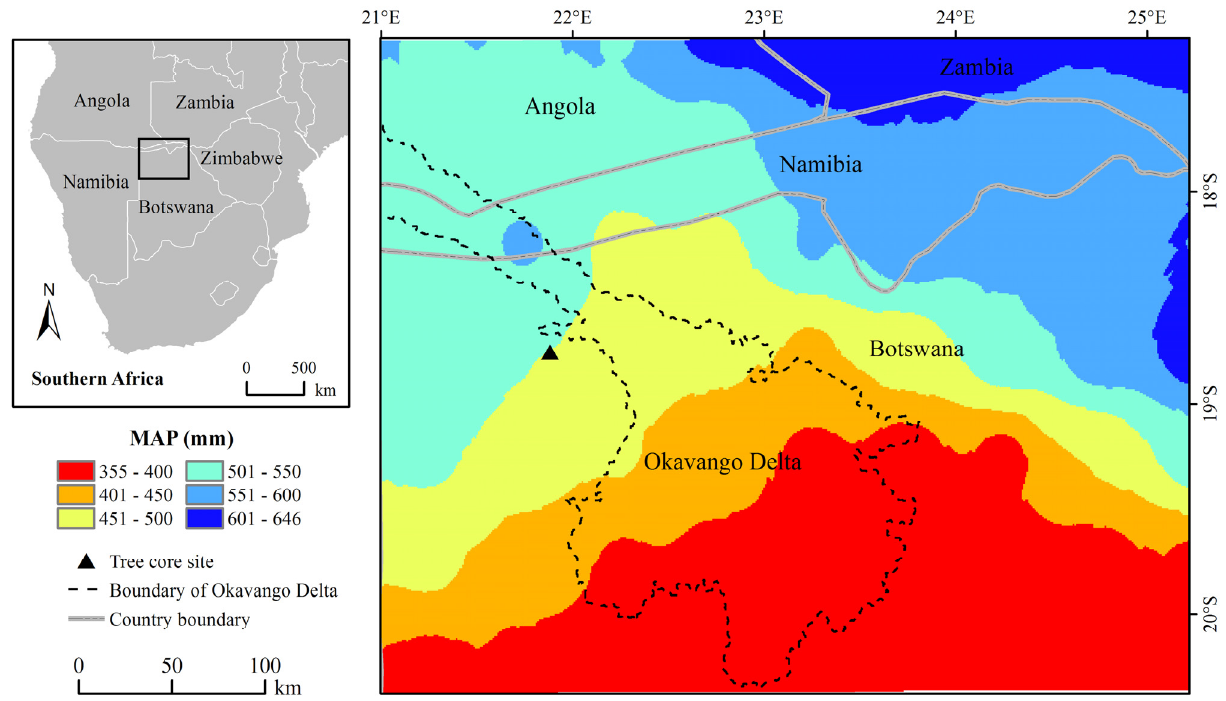
Figure 1. Study area located in southern Africa. The landscape scale analysis examines the terminus of the Okavango Delta and is combined with an analysis of tree cores collected west of the